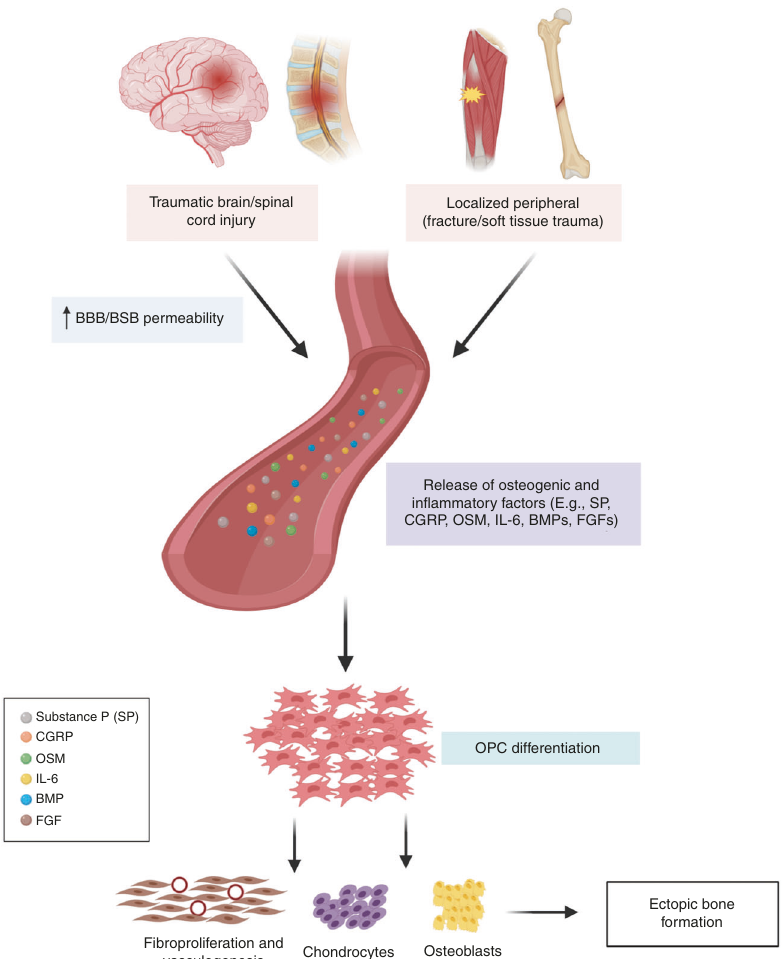
Fig. 1 Proposed mechanism for NHO development. Simultaneous injury to the CNS and peripheral sites triggers the release of osteogenic and in fl ammatory factors including; SP, CGRP, OSM, IL-6, BMPs and FGFs. The in fl ux of osteogenic and in fl ammatory factors, initiates the differentiation of OPCs into fi broblasts which is mediated by fi broblast growth factors (FGFs). This in fl ux also elicits angiogenesis, which results in an increase in oxygen tension, triggering the differentiation of OPCs into chondrocytes which undergo hypertrophy and form a cartilage matrix. This cartilaginous matrix provides a structural framework for the formation of blood vessels, osteoblast proliferation and differentiation and formation of ectopic bone (created with